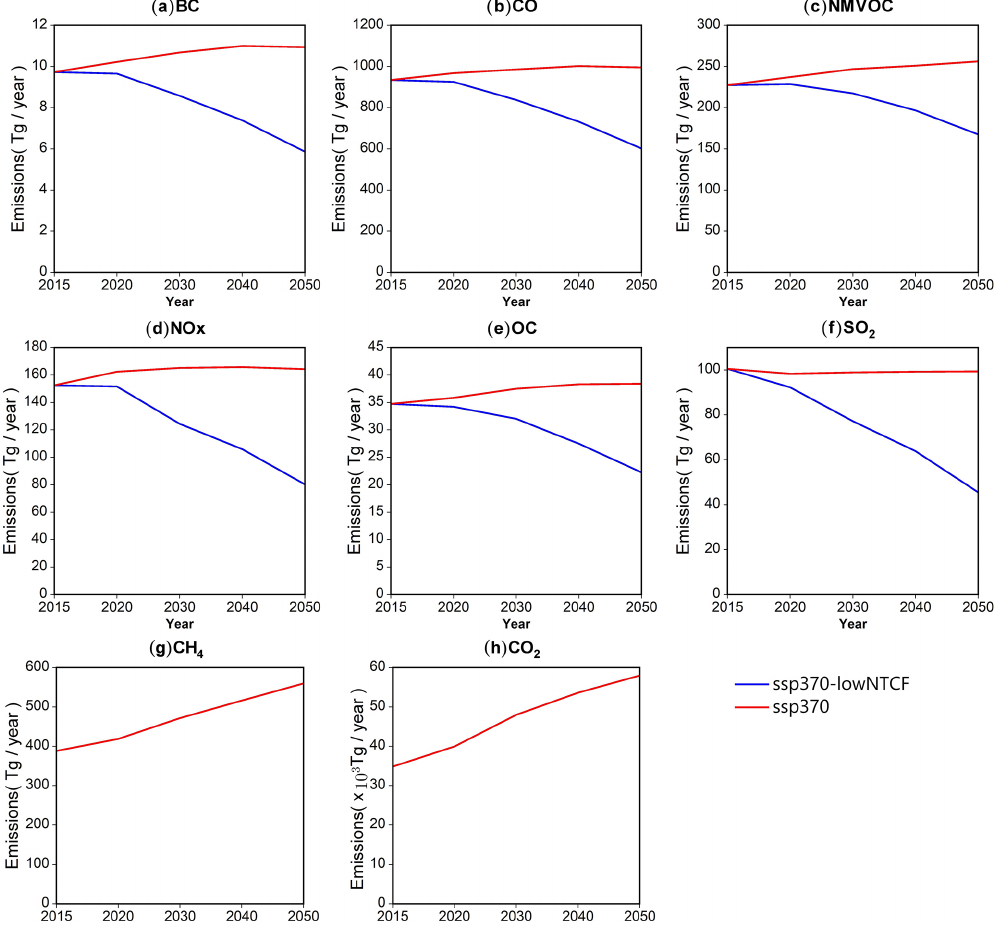
Figure 1. Time series of global annual emissions of (a) BC, (b) CO, (c) NMVOCs (non-methane volatile organic compounds), (d) NO x , (e) OC, (f) SO 2 , (g) CH 4 , and (h) CO 2 from 2015–2050 under the SSP3-7.0 (solid red line – ssp370) and SSP3-7.0-lowNTCF (solid blue line – ssp370-lowNTCF) scenarios. Only the red line is visible in (g) and (h) as ssp370 and ssp370-lowNTCF overlap.